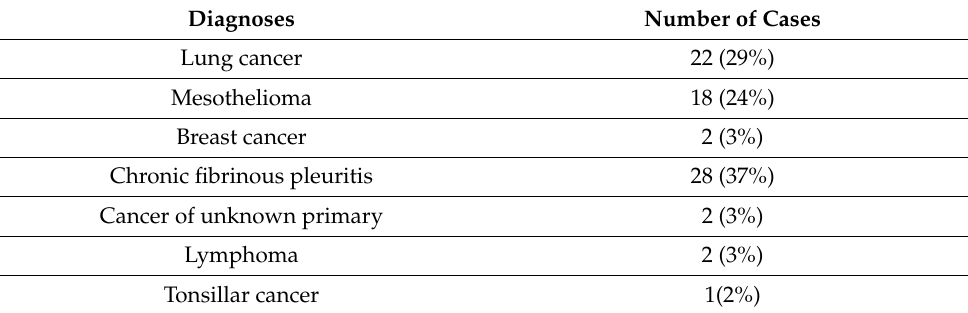
Table 1. Diagnoses from thoracoscopic biopsies. Diagnoses